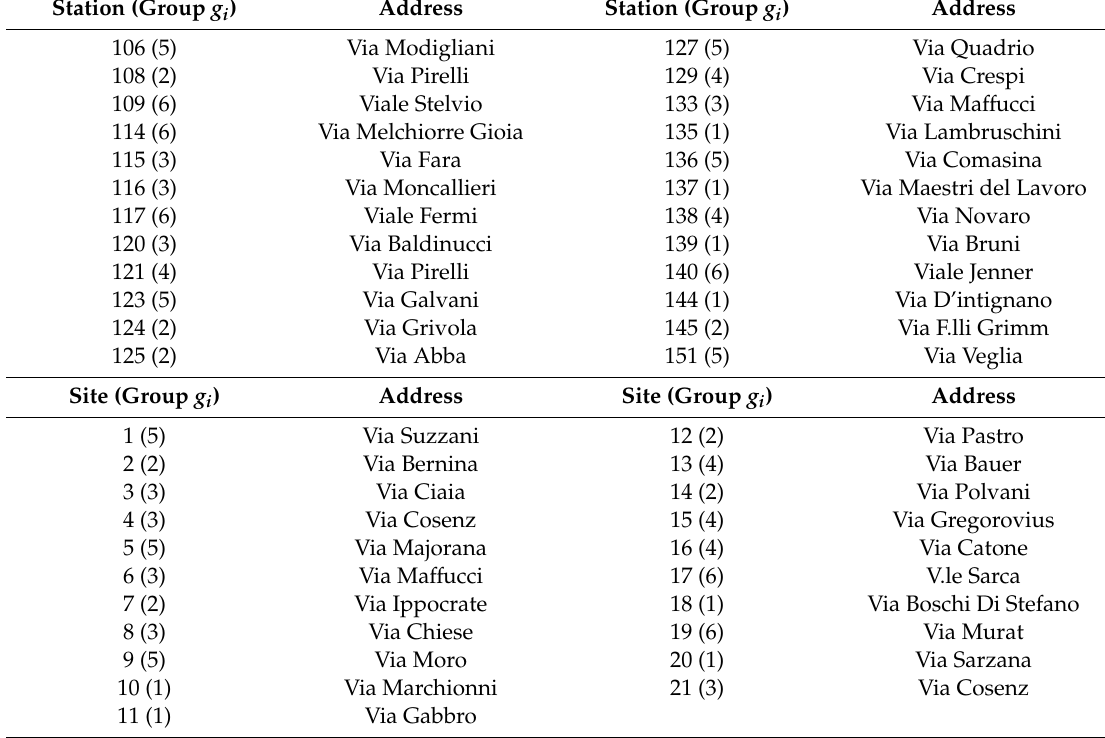
Table 3. Location of noise monitoring stations and measurement sites (cfr. Figure 9). The group index of each sensor and site are indicated within parenthesis.